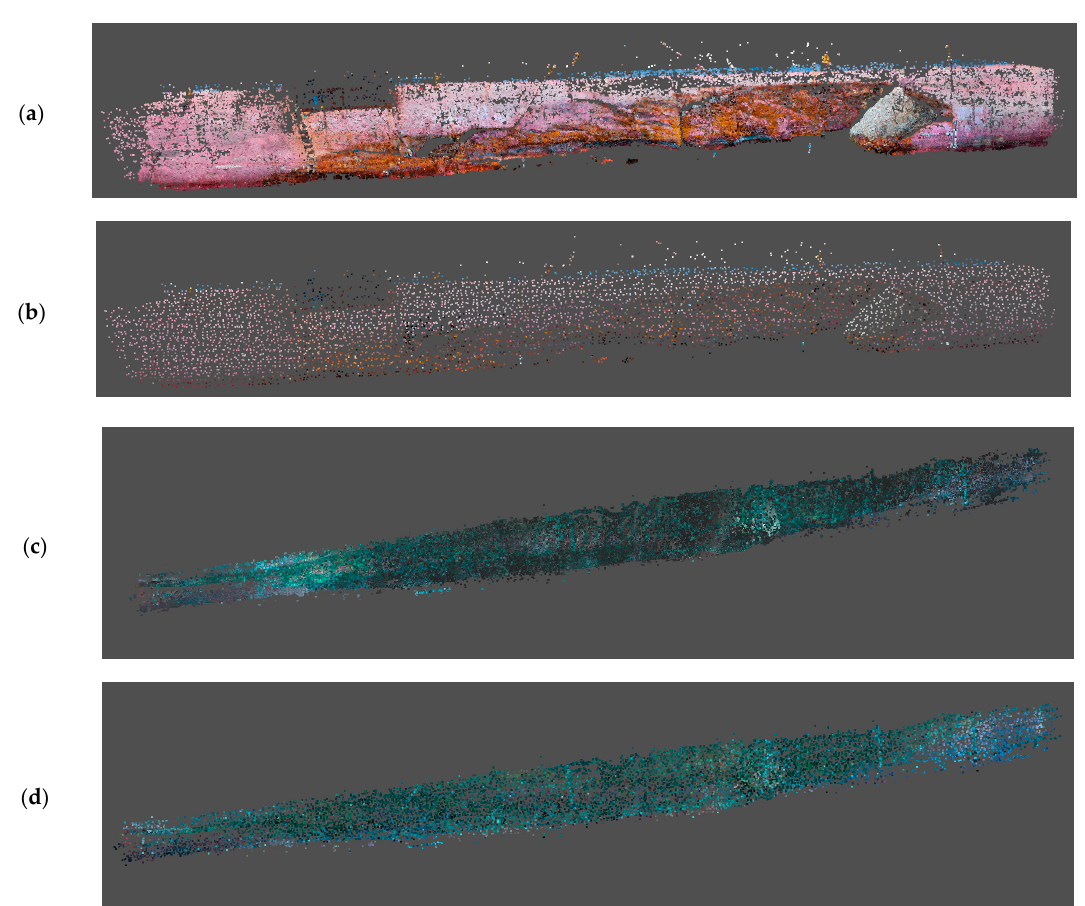
Figure 10. Sparse tie point cloud of above and underwater photogrammetric models before ( a , c ) and after ( b , d ) the filtering procedure. Table 1. Filtering of the sparse tie point clouds of above and underwater photogrammetric models.